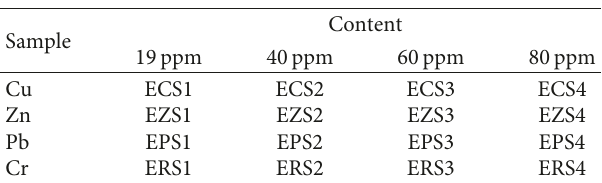
Figure 2: Anaerobic digestion flow diagram (SBS: samples without metal addition). Table 1: Sample labels.